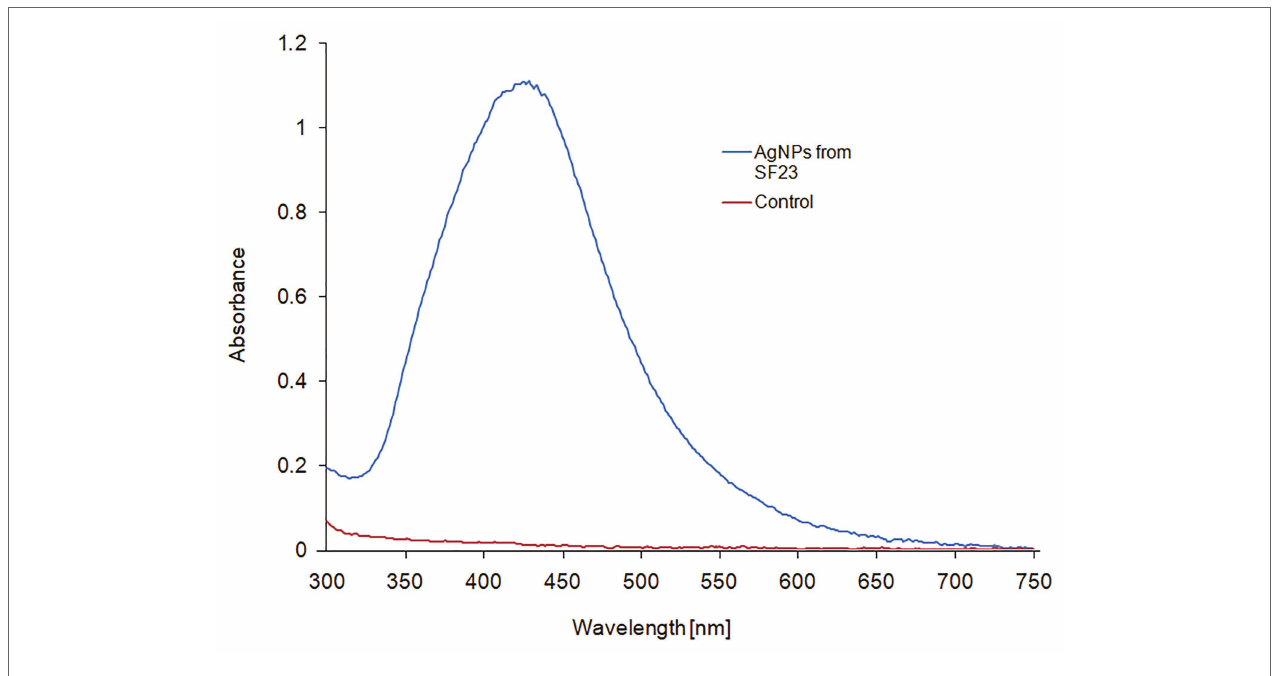
FIGURE 1 | UV-Vis spectrum of biosynthesized AgNPs.